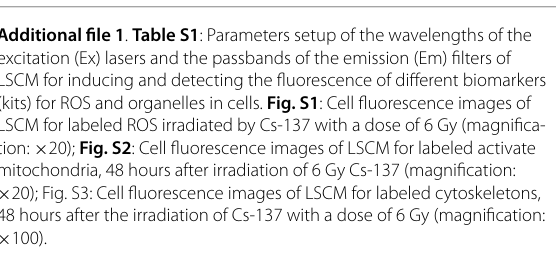
Fig. 6 Cell viability (in vitro clonogenic assay) of A431 with GNPs uptake; cell SF (8 days after Cs‑137 irradiation) versus radiation dose. Control group: cells without GNPs co‑culture. ★ : P < 0.02